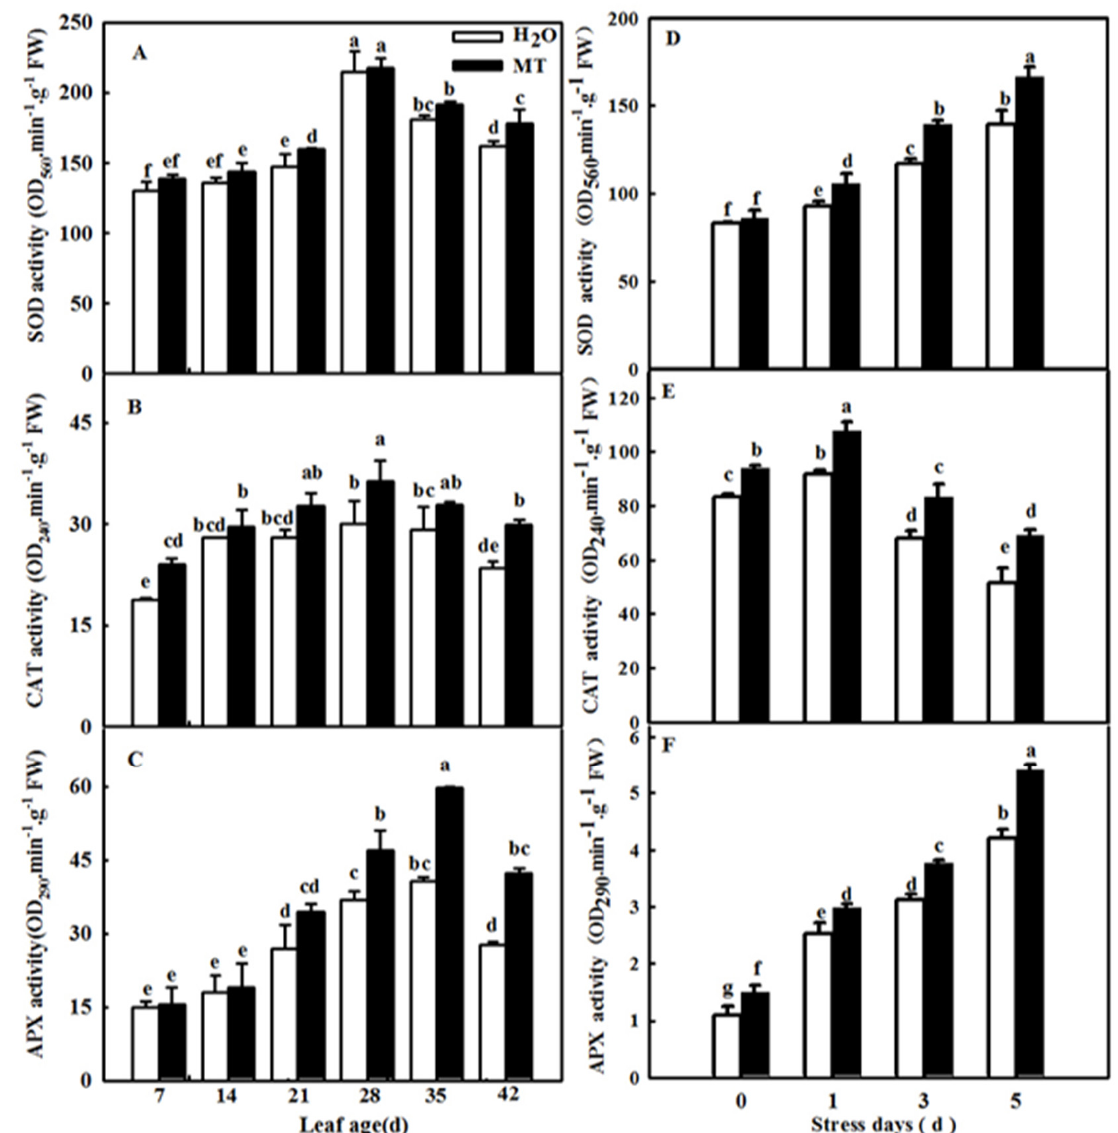
Figure 10. The effect of exogenous MT on antioxidant enzyme activity in senescent leaves of cucumber plants induced by age or darkness. ( A – C ) SOD, CAT, and APX activities in different age leaves; ( D – F ) SOD, CAT, and APX activities in leaves under darkness. At the two-leaf stage, the cucumber seedlings were planted in a solar greenhouse or started to be treated with MT. At the three-leaf stage, the new leaf at the top of cucumber plants was labeled 0 days and then labeled at 7, 14, 21, 28, 35, and 42 days in a solar greenhouse; plants were sprayed with 100 µ mol · L − 1 MT every 7 days, and plants treated with H 2 O were the control. Meanwhile, the seedlings were treated with H 2 O and 100 µ mol · L − 1 MT, respectively, 2 times, and then seedlings were displaced into growth chambers and treated with dark condition (day/night temperature: 25 ◦ C/18 ◦ C). The 2nd leaf samples were taken at 0, 1, 3, and 5 days. All values shown are mean ± SD ( n = 3). a–g indicate that mean values are significantly different among samples ( p <